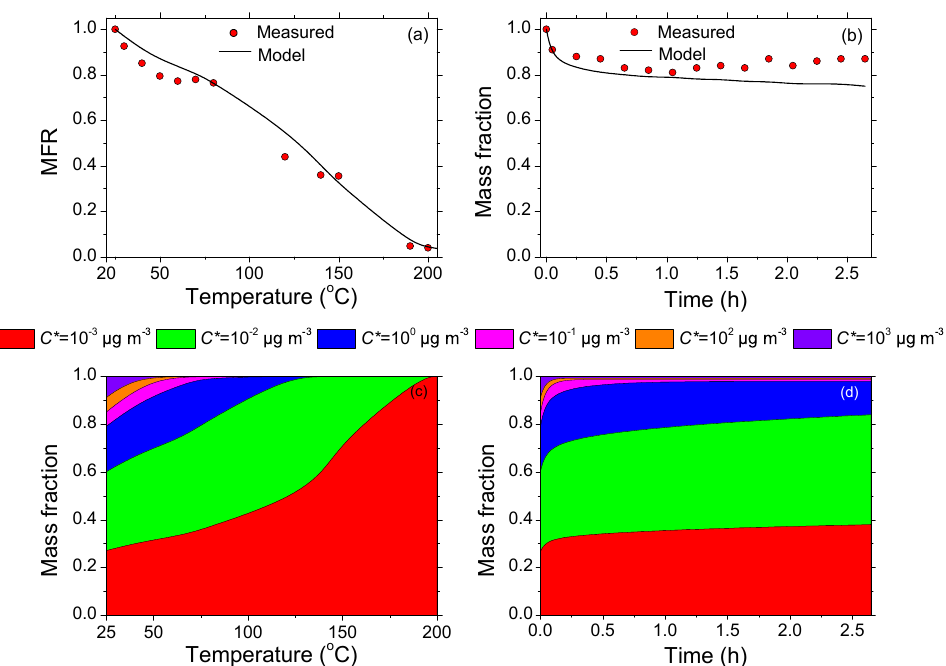
Figure 4. (a) Thermogram of the OA TD measurements of Experiment 1. Red circles represent the loss-corrected measurements and the black line represents the best fit estimated by the model of Karnezi et al. (2014) (b) Mass fraction during isothermal dilution as a function of time of Experiment 1. Red circles represent the loss-corrected measurements and the black line is the estimated best model fit. (c) COA mass fraction for different effective saturation concentrations as a function of TD temperature. Red represents the contribution of the effective saturation concentration C ∗ = 10 − 3 µgm − 3 , green the contribution of the C ∗ = 10 − 2 µgm − 3 , blue the C ∗ = 1µgm − 3 , magenta the C ∗ = 10µgm − 3 , orange the C ∗ = 10 2 µgm − 3 , and violet the C ∗ = 10 3 µgm − 3 . (d) COA mass fraction for different effective saturation concentrations as a function of time during isothermal